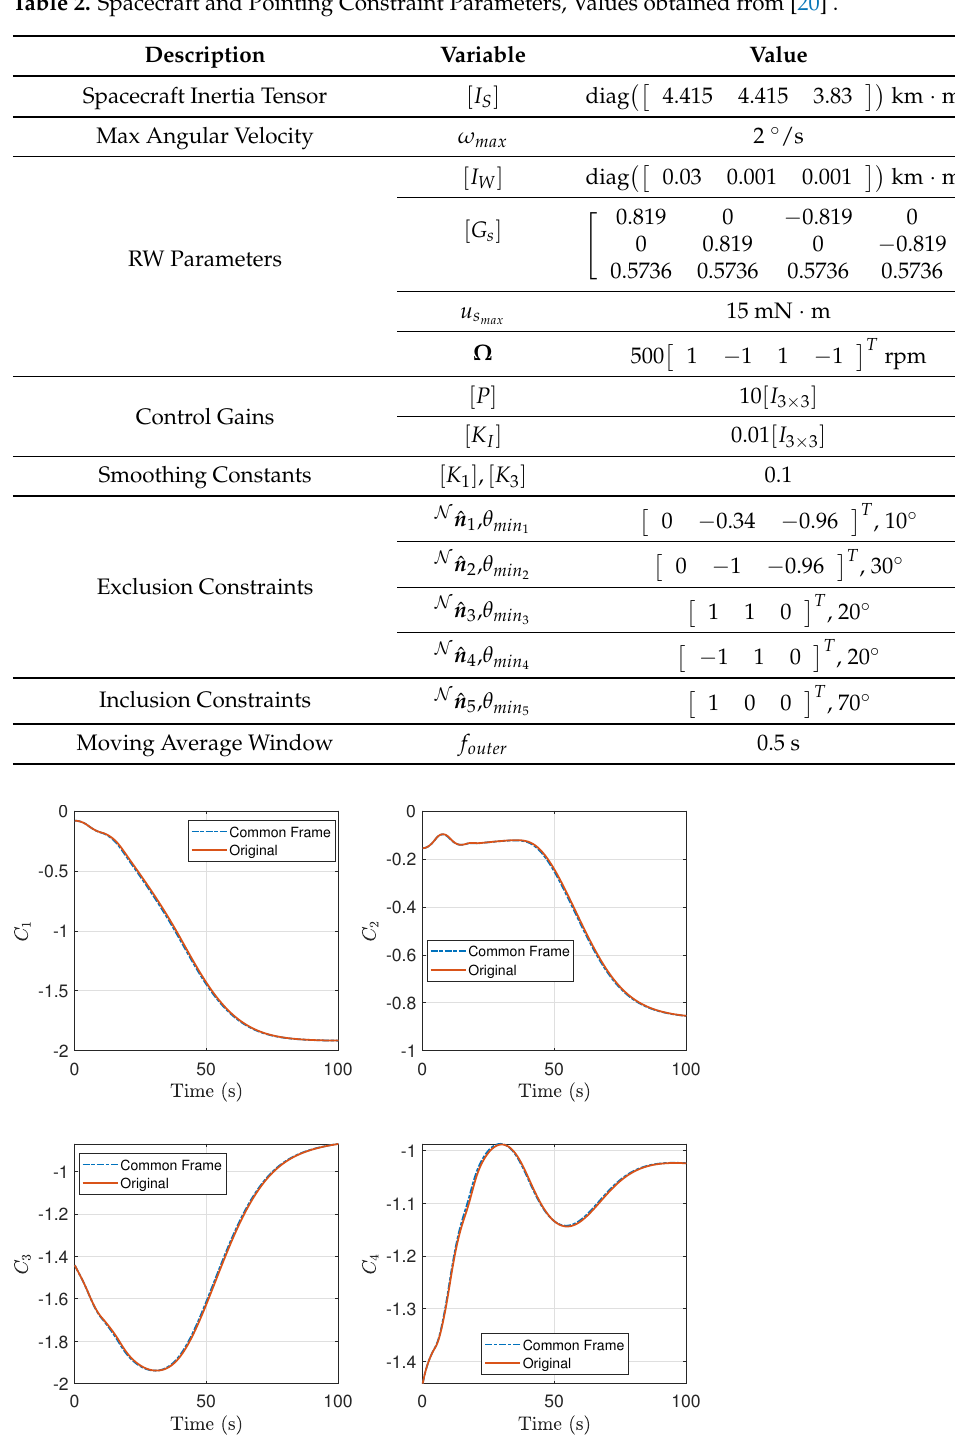
Figure 10. Comparison of Equation (33) in the Common Frame and the Original